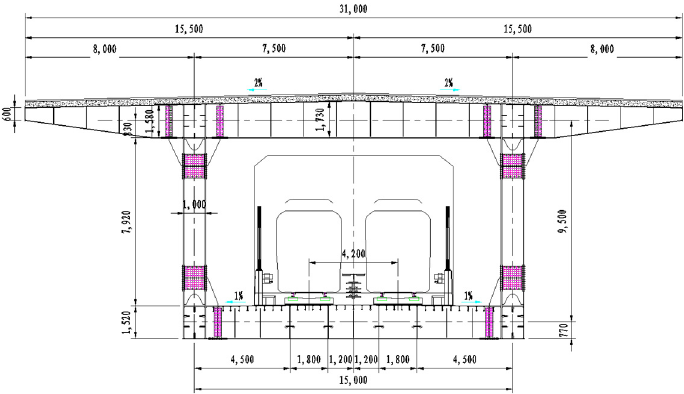
Figure 2. Mid-span cross section of main bridge (Unit: mm).